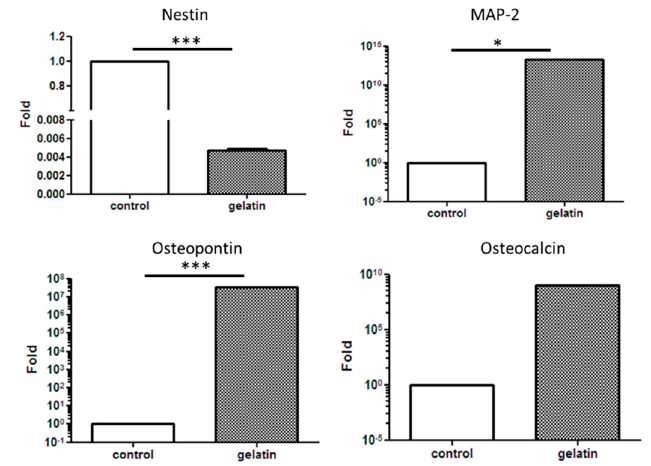
Figure 5. Analysis of the gene expression of nestin, microtubule-associated protein 2 (MAP-2), osteopontin, and osteocalcin in human adipose stem cells cultured on the gelatin scaffold. Data represent mean ± S. D., * P < 0.05, *** P <0.001 compared with control group.